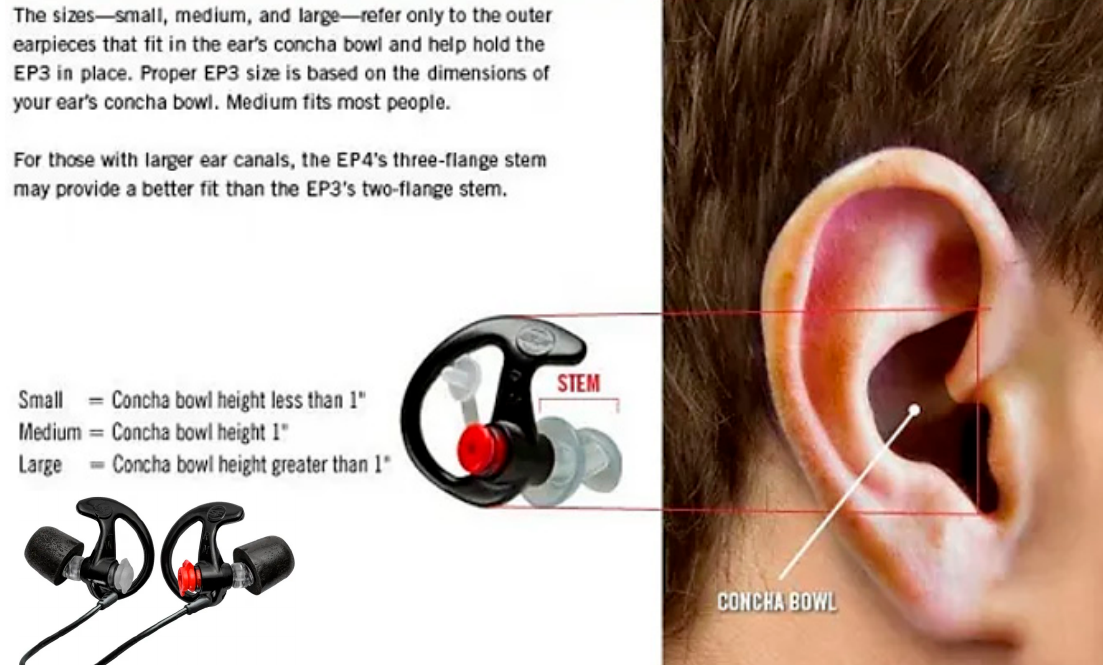
Figure 5. Surefire EarPro EP7 Ultra Sonic Defenders